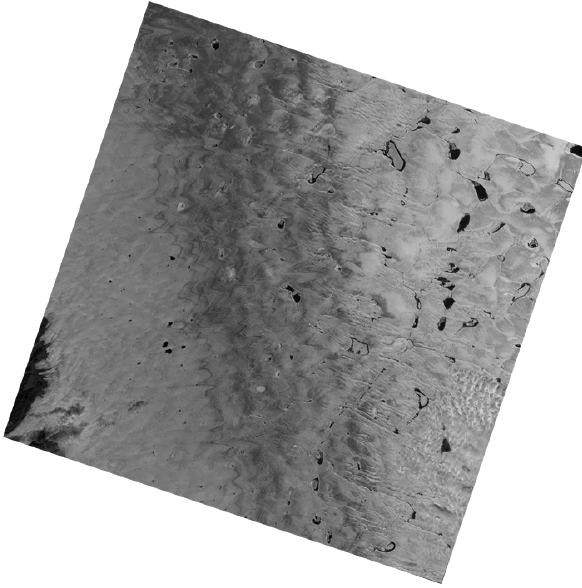
Fig. 10. ASTER image of 21 July 2002. In the left corner is a part of the glacier Inugpait Qˆuat, around 67.5 ◦